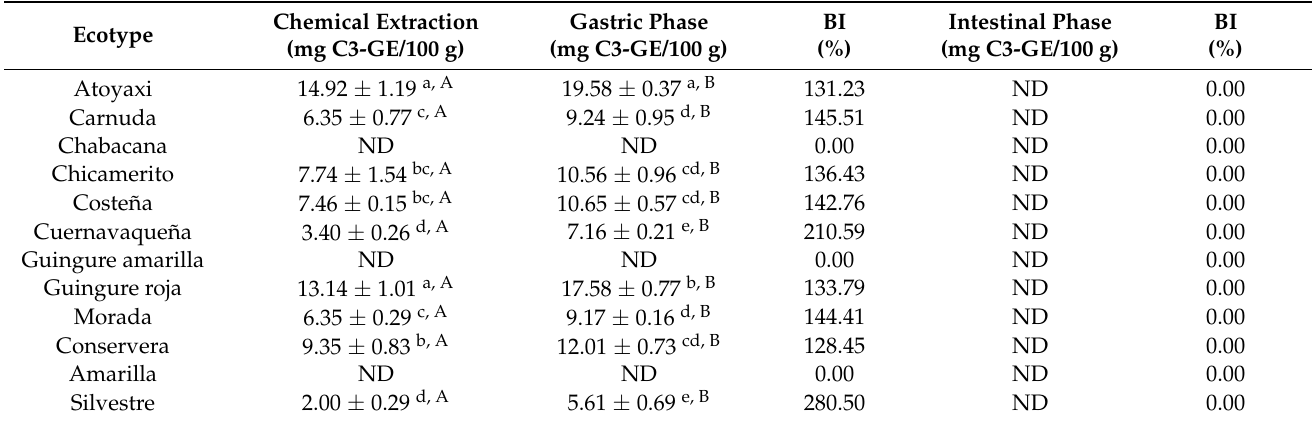
Table 6. Total anthocyanin content and bioaccessibility index of 12 ecotypes of S. purpurea L. before and after in vitro